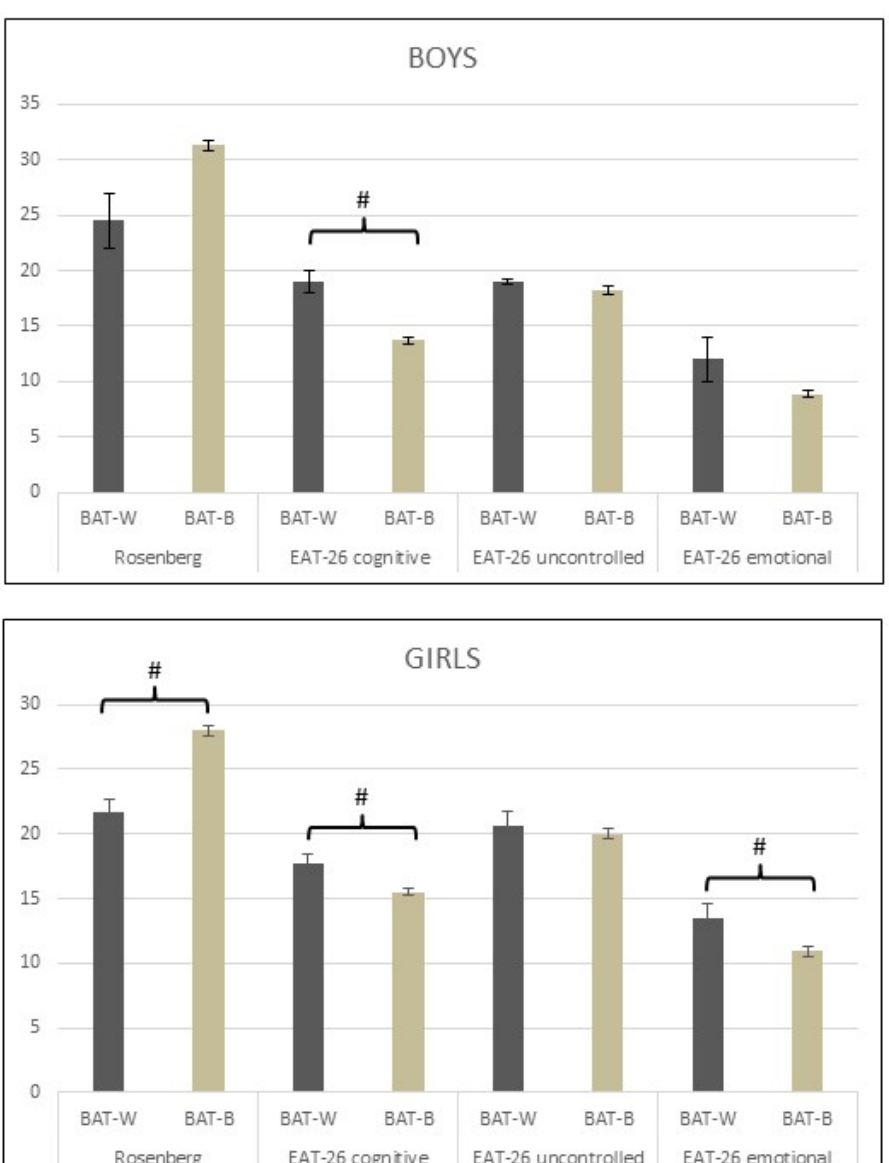
Figure 4. The analysis revealed significant differences between girls BAT-W (those with worse attitudes toward their body) and BAT-B (those with better attitudes toward their body) subgroups in Rosenberg Self-Esteem Scale and Eating attitudes cognitive restraints and emotional eating subscales. Additionally, our data showed significant differences between boys BAT-W and BAT-B subgroups in the cognitive restraints subscale of eating attitudes. (BAT-W: those with worse attitudes toward their body, BAT-B: those with better attitudes toward their body). #: significant difference, p < 0.05. Cognitive restraint, similarly to self-esteem, showed strong associations with subjec- tive body shape (b = − 0.22, t = − 4.32, p < 0.001) and gender (b = 0.26, t = 5.27, p <